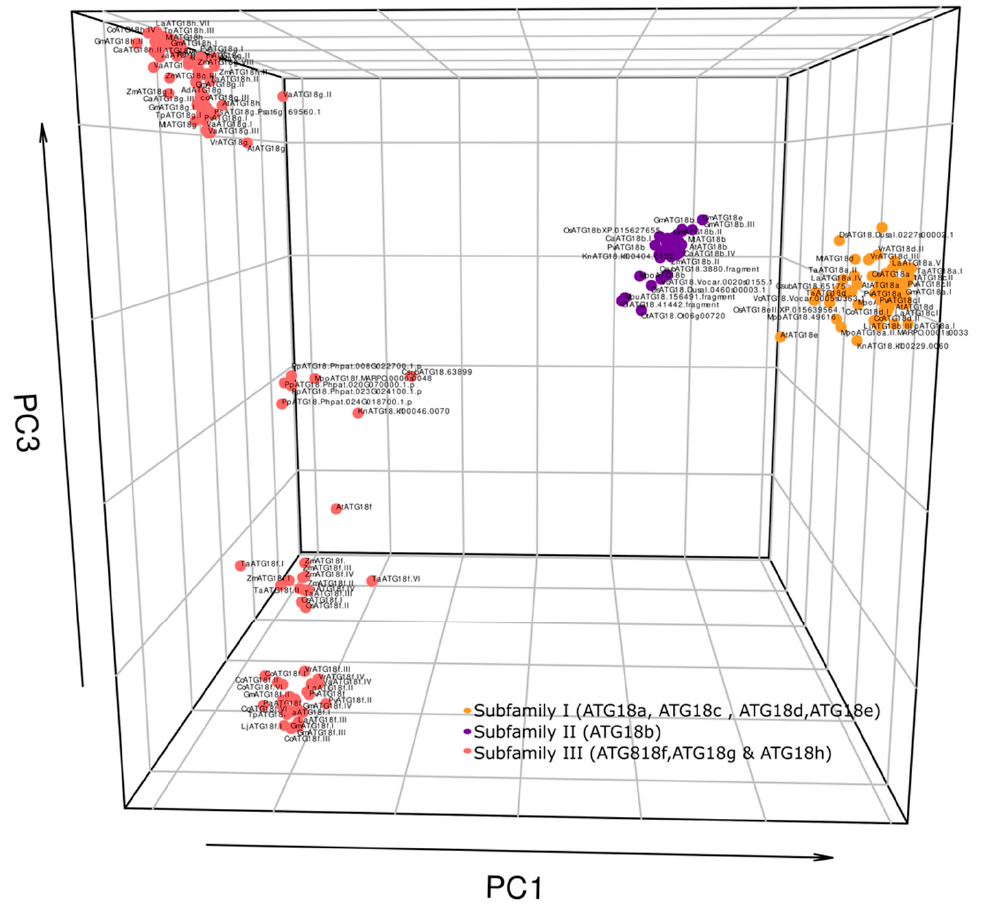
Figure 6. Three-dimensional representation of 280 ATG18 proteins from different plant species analyzed by multidimensional scaling using Bios2mds. The ATG18 subfamilies are color-coded as follows: Subfamily I (yellow), subfamily II (purple) and subfamily III (red). PC, principal component. The axes are the principal components (PC): x -axis (PC1), y -axis (PC2) and z -axis (PC3).